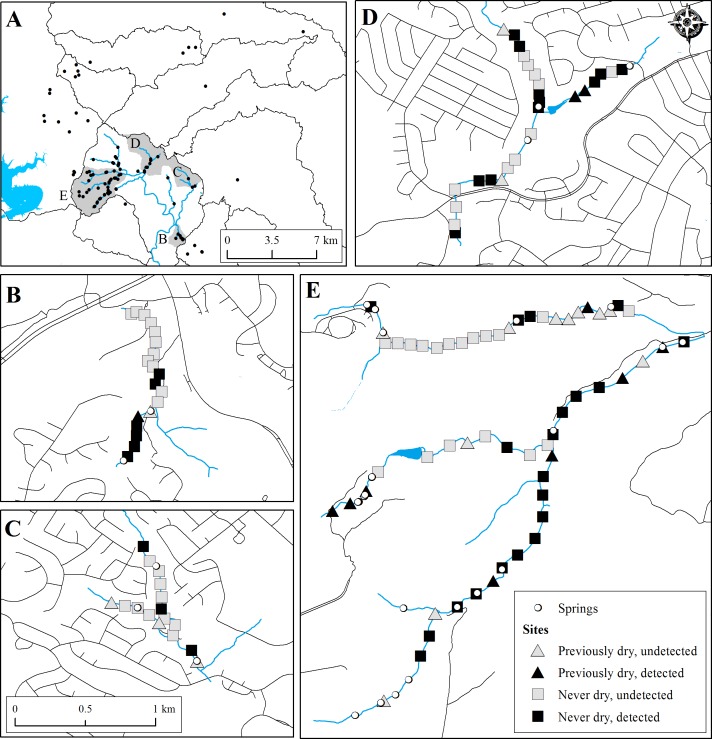
Map of E. tonkawae range (A) and occupancy study sites (B–E).(A) All known localities of E. tonkawae, watershed boundaries, and creek centerlines for major tributaries of Bull Creek. (B–E) Survey sites indicating E. tonkawae detection, location of known springs, and whether site was dry during any prior survey among sub-watersheds of Bull Creek. (B) Barrow Hollow. (C) Trib. 2. (D) Trib. 4. (E) Trib. 7 (top) and Mainstem/Trib. 8 (bottom). Road centerlines adjacent to tributaries are shown as an indicator of urbanization within each catchment.